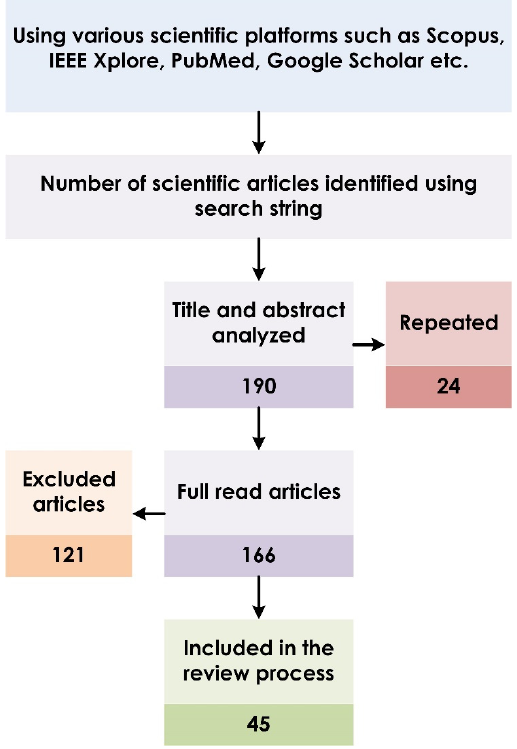
Figure 2. Article selection process based on PRISMA guidelines.